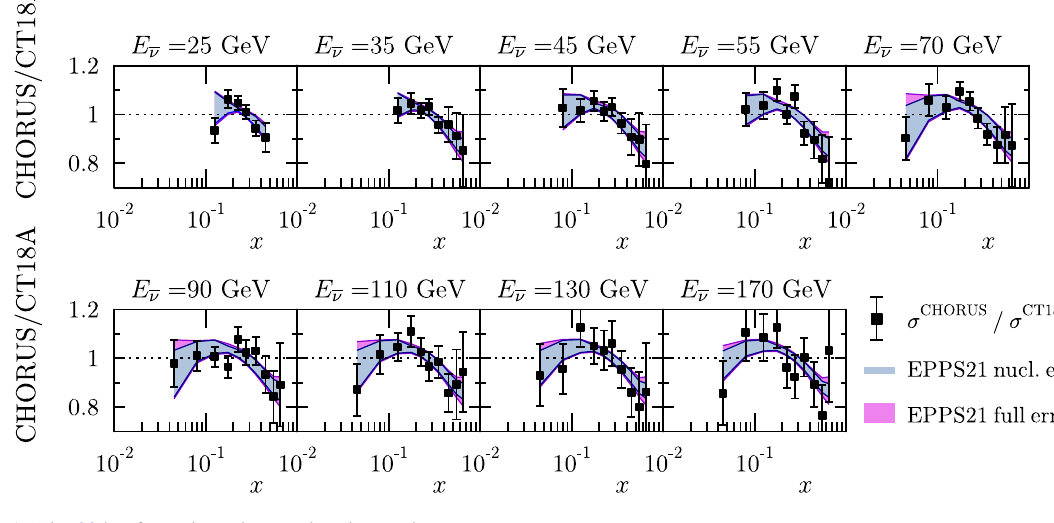
Fig. 23 As Fig. 22 but for antineutrino–nucleus interaction